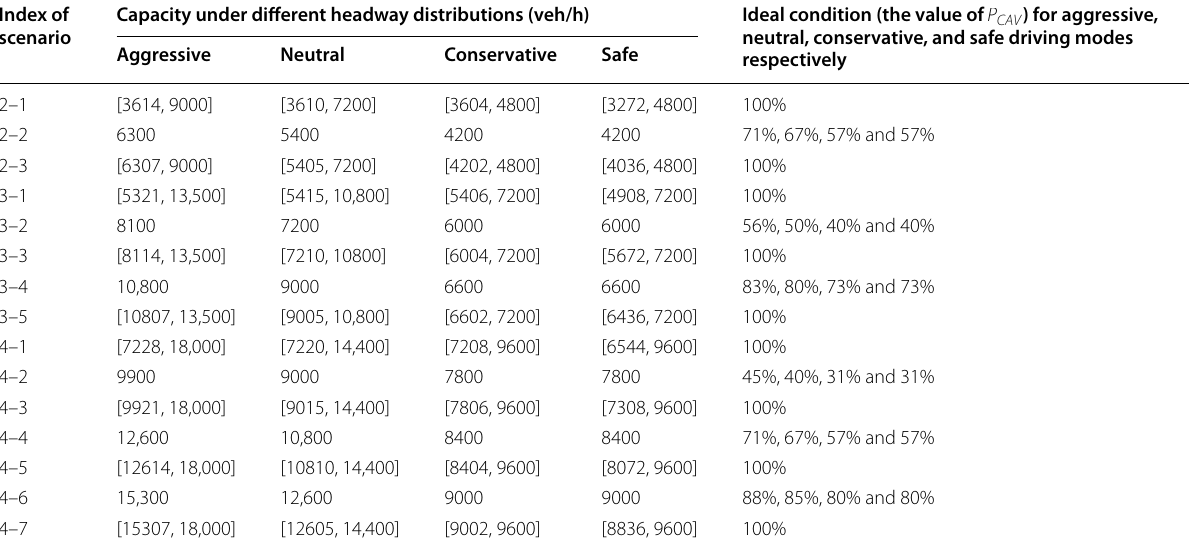
neutral, conservative, and safe driving modes